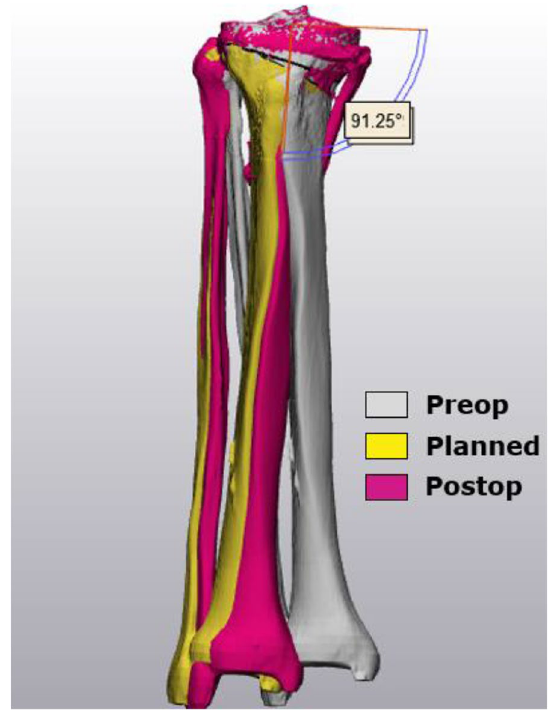
Table 1 Baseline patient characteristics. Severity of OA was scored according to the Kellgren- Lawrence